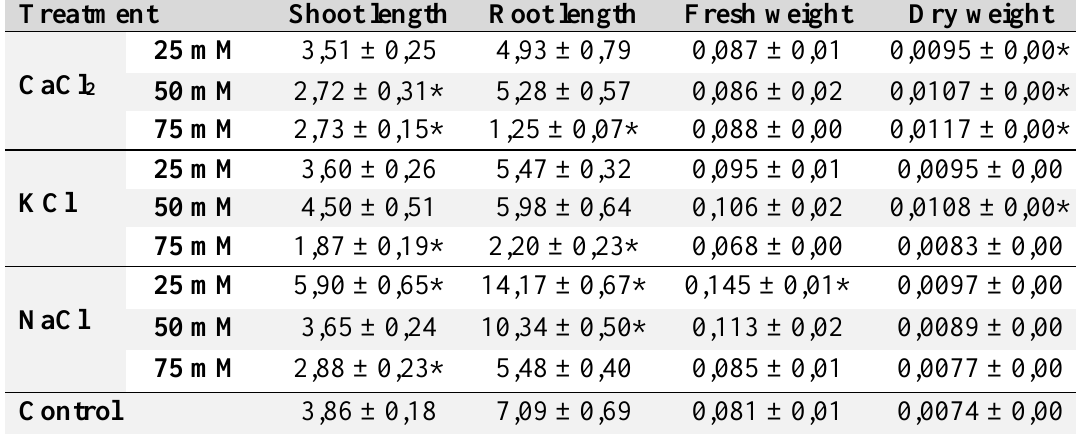
, KCl and NaCl on shoot and root length 2